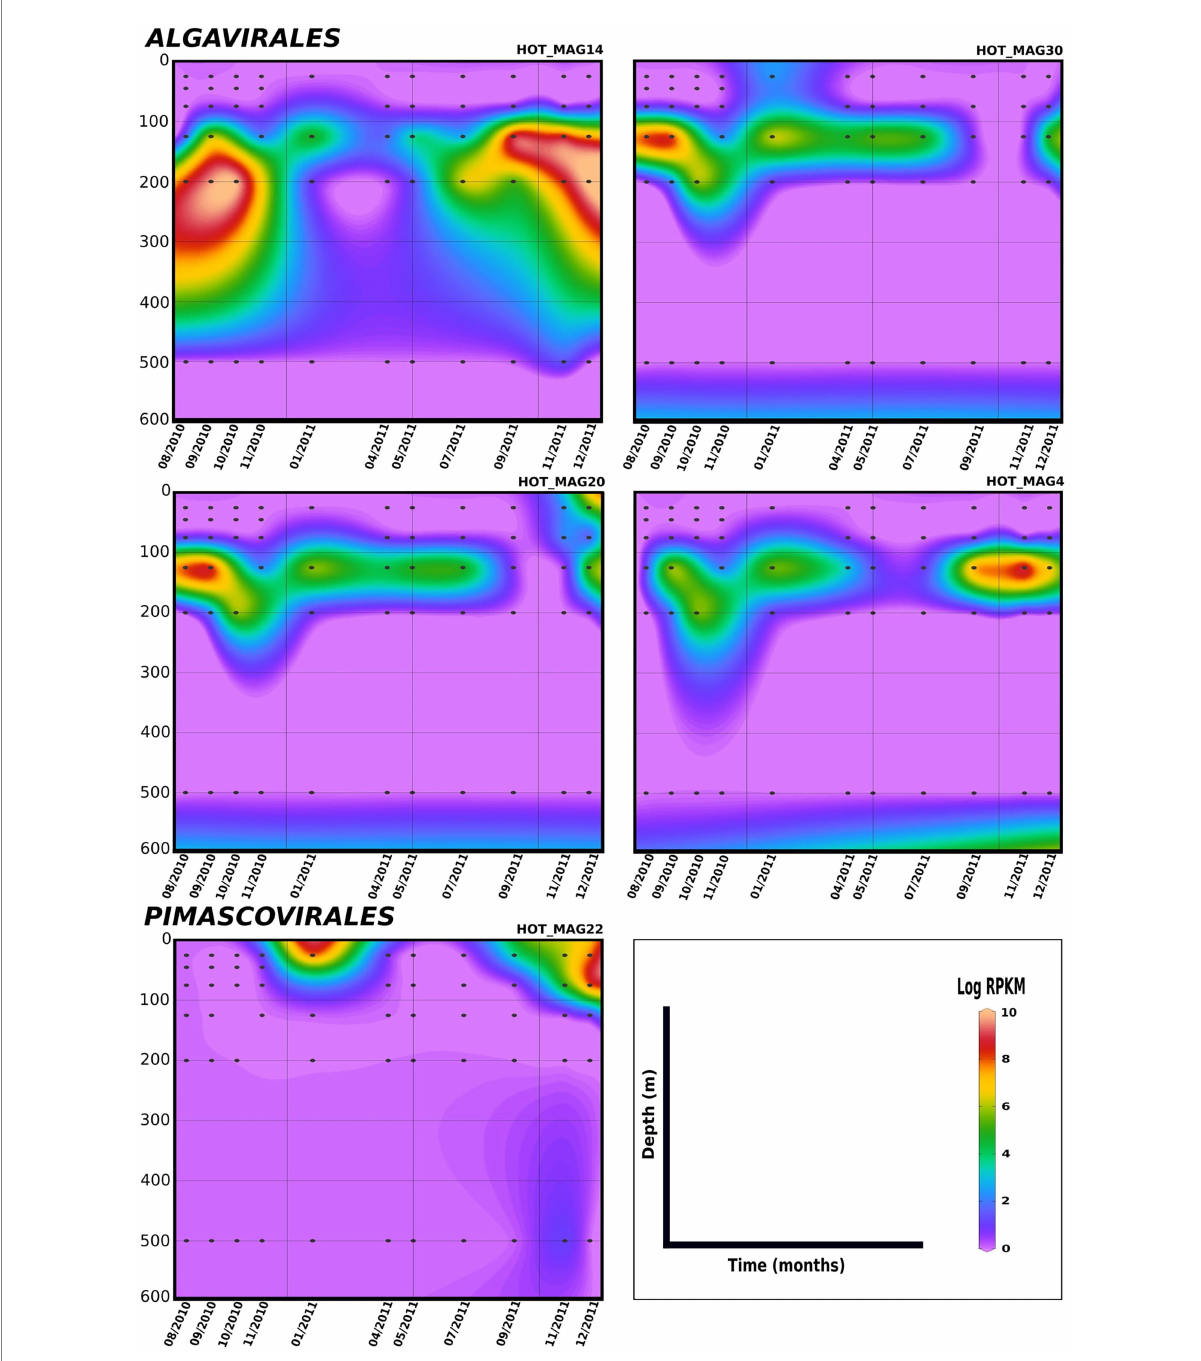
FIGURE 6 Distribution of 11 MAGs in the orders Algavirales and Pimascovirales in a 1.5-year sampling from St. ALOHA. Time series plots were drawn based on the results from mapping Hawaiian Ocean Time series metagenome dataset onto the 11 MAGs (see Materials and methods for details). The total abundance of the MAGs was calculated based on RPKM. Y-axis and x-axis represent depths(m) and latitudes, respectively and the colorful bar refers to the log of total abundance (RPKM) for each of the MAGs (high abundance = red and low abundance = purple). Only the distribution of the MAGs between 0–600 m were shown in the